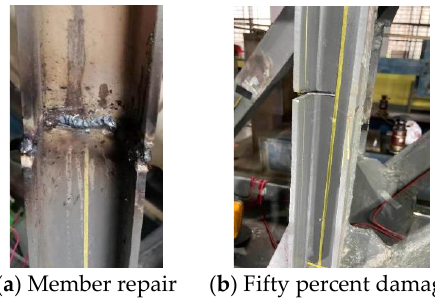
Figure 34. Photograph of member repair and damage.